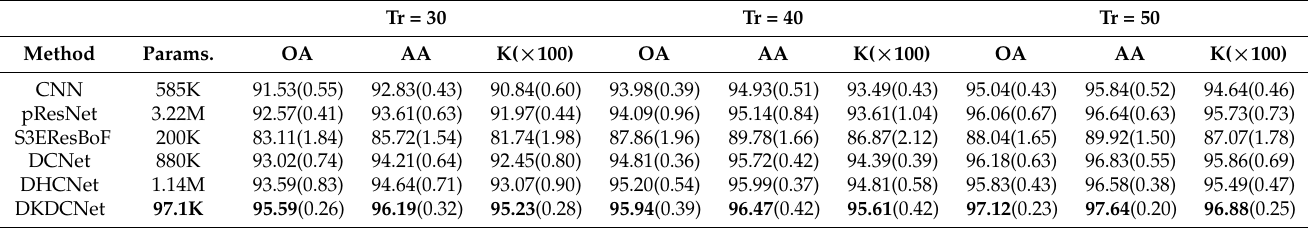
Table 3. Classification results and number of parameters obtained for UH scene.